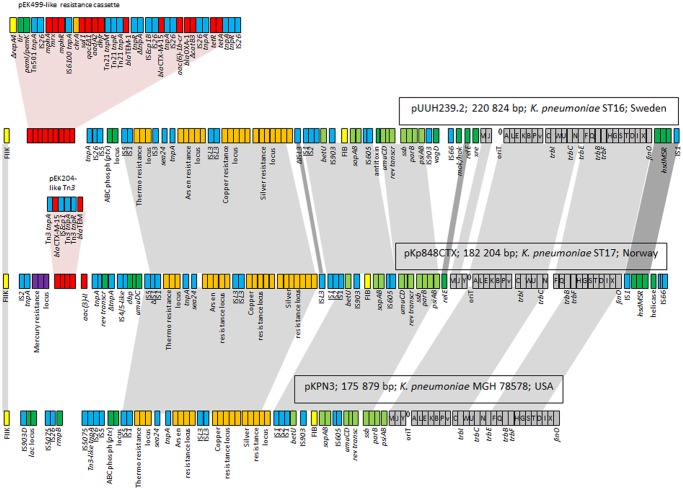
Major structural features of pKp848CTX compared with pKPN3 and pUUH239.2.Yellow boxes indicate replicase genes, grey boxes indicate the transfer region, light green boxes indicate core genes common in the three plasmids, dark green boxes indicate core genes not common in all three plasmids, orange boxes indicate heavy metal- and thermoresistance gene clusters, purple boxes indicate mercury resistance gene cluster, red boxes indicate antibiotic resistance genes and blue boxes indicate IS and transposon related genes. Light grey shadings indicate regions common for all three plasmids. Dark grey shadings indicate regions common among two of the plasmids.